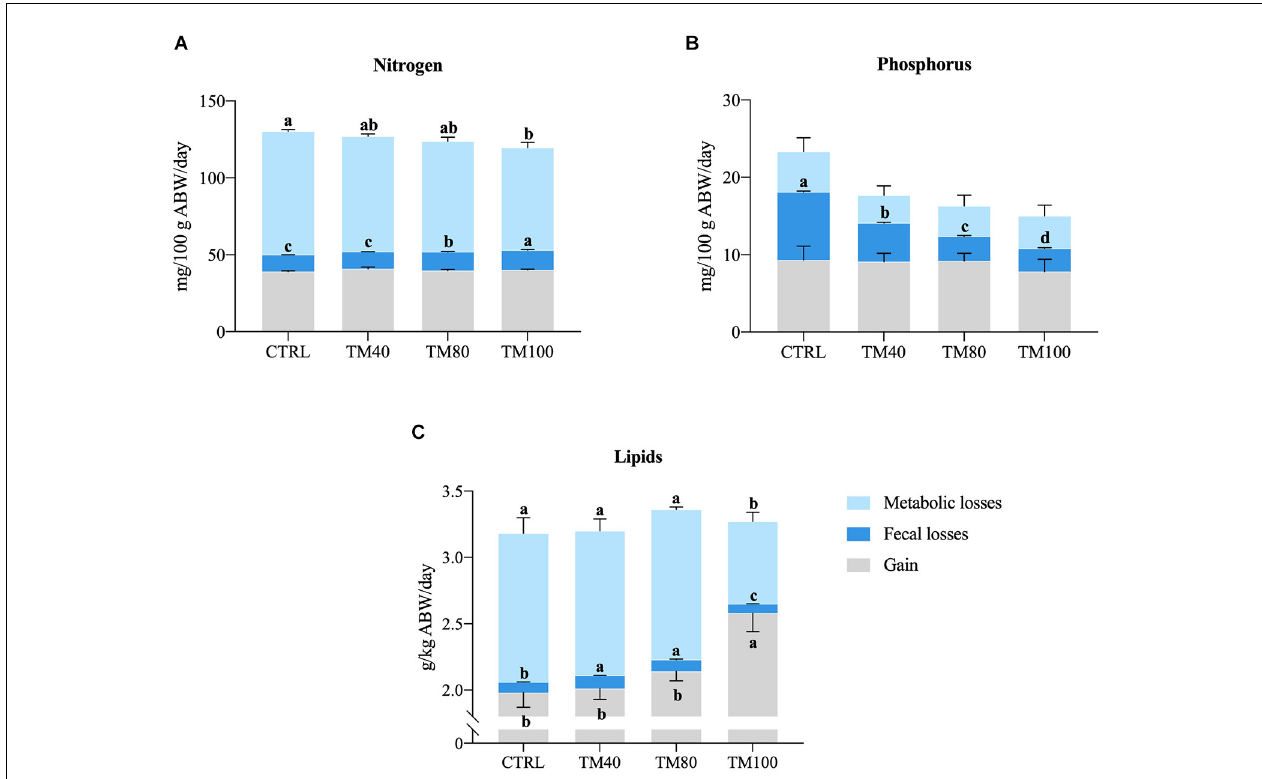
FIGURE 2 | Daily nitrogen (A) , phosphorous (B), and lipids (C) balance of European sea bass fed experimental diets. Bars represent means ± SD; n = 3 (pools of 5 fish/replicate). Labeled means without a common superscript letter differ significantly, p < 0.05.